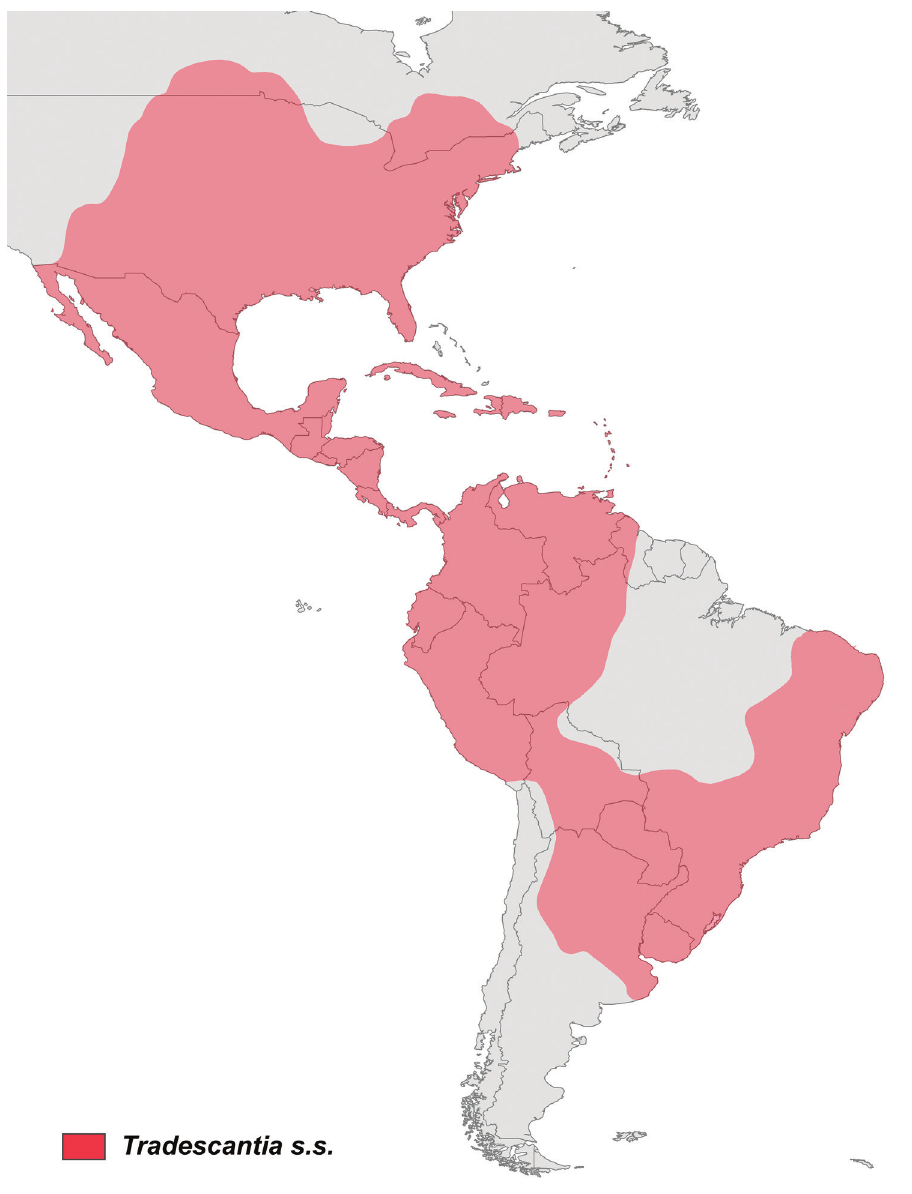
Figure 7. Distribution of Tradescantia L. emend.